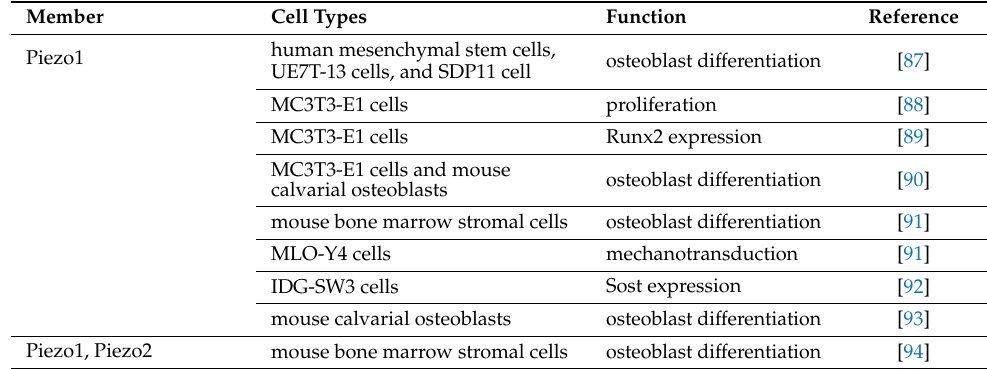
Table 5. Functional expression of Piezo channels in osteoblast lineage